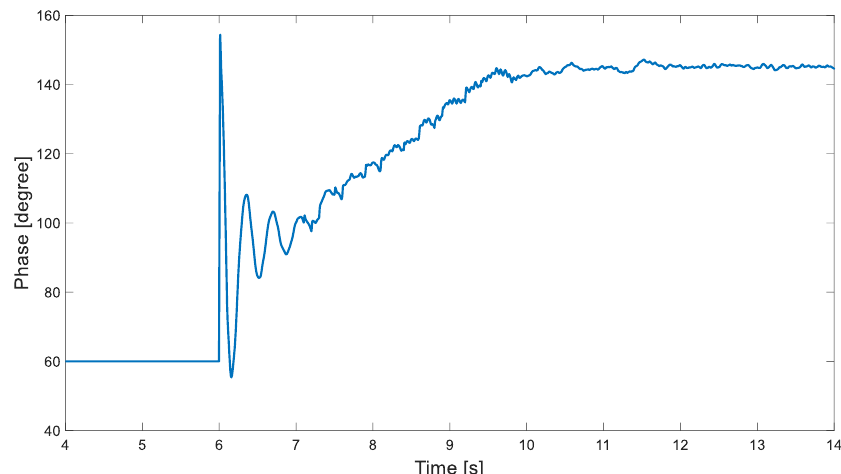
Figure 8. φ SSD related to the proposed control scheme shown in Figure 3.